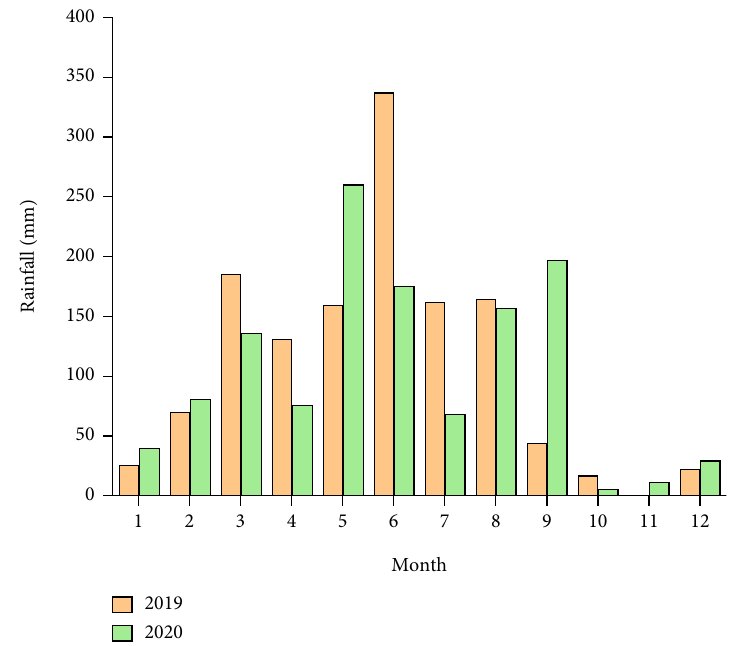
Figure 1: Monthly rainfall data of Xiping Town, Anxi County, 2019 –